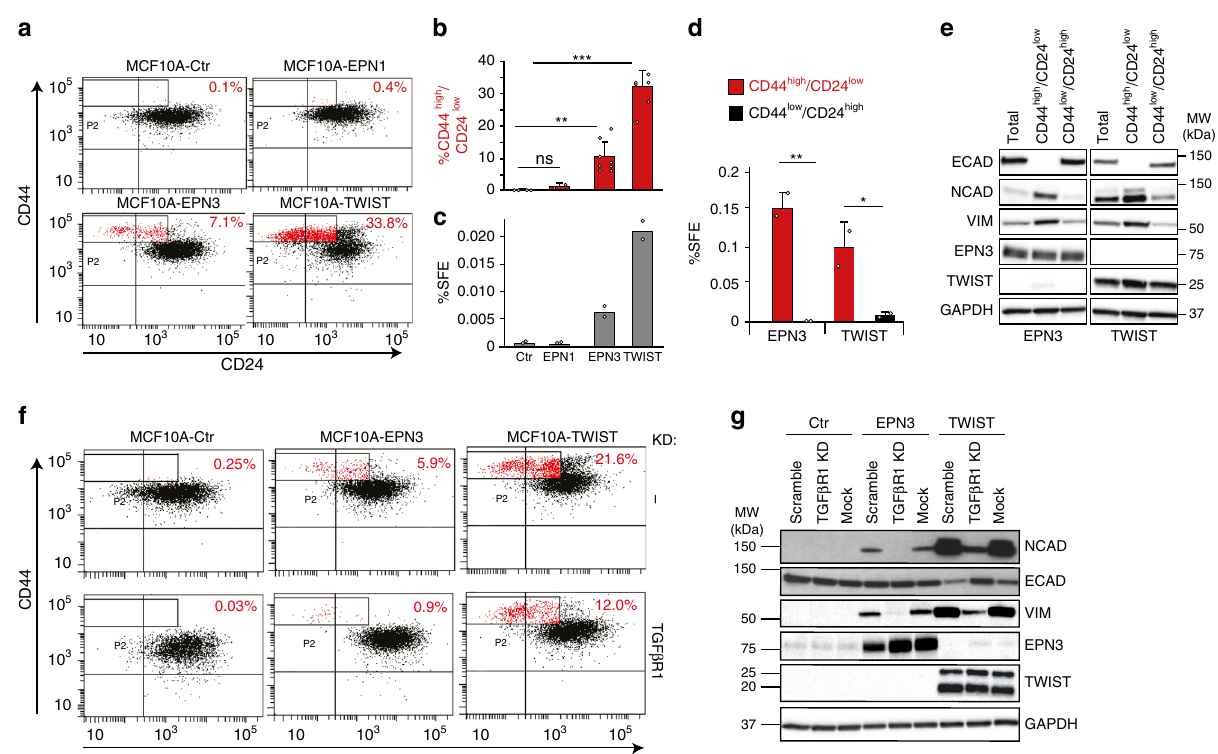
Fig. 8 EPN3 overexpression expands a cellular compartment with features of CSCs. a Representative bi-parametric (CD44/CD24) FACS analysis of MCF10A cells expressing the indicated constructs. The CD44 high /CD24 low population is boxed and shown in red, with the relative percentage. See also Supplementary Fig. 10A for a different representation of the results. b The size of the CD44 high /CD24 low population (measured by FACS as in a ) in the indicated samples is reported as a percent of the total. Mean± S.D. of at least two independent experiments is shown ( N , Ctr = 4, EPN1 = 2, EPN3 = 8, TWIST = 6). P value, each pair Student ’ s t test two-tailed. c Mammosphere assay on MCF10A cells expressing the indicated constructs. Results are expressed as mean sphere-forming ef fi ciency (SFE) of two independent experiments. P value, each pair Student ’ s t test two-tailed. d Mammosphere assay on the CD44 high /CD24 low and CD44 low /CD24 high FACS-sorted subpopulations of MCF10A cells expressing the indicated constructs. Results are expressed as mean SFE ± S.D. of two independent experiments, each performed in technical triplicates. P value, each pair Student ’ s t test two-tailed. e The indicated FACS-sorted populations from MCF10A-EPN3 or -TWIST cells were analyzed by IB as shown and compared to the total unsorted population. GAPDH, loading control. This panel was assembled from samples run on the same gel by splicing out the irrelevant lanes, as shown by the black lines. MW markers are shown on the right. f Representative bi-parametric (CD44/CD24) FACS analysis of the indicated cell lines, mock-silenced (Ctr, top) or silenced for TGF β R1 (bottom). The CD44 high /CD24 low population is boxed and shown in red, with the relative percentage. Results are representative of two independent experiments. g MCF10A cells expressing the indicated constructs were transfected with a non-targeting oligo (scramble), mock- transfected (mock), or silenced for TGF β R1 (TGF β R1 KD) and analyzed by IB. GAPDH, loading control. MW markers are shown on the left. Source data are provided as a Source Data fi